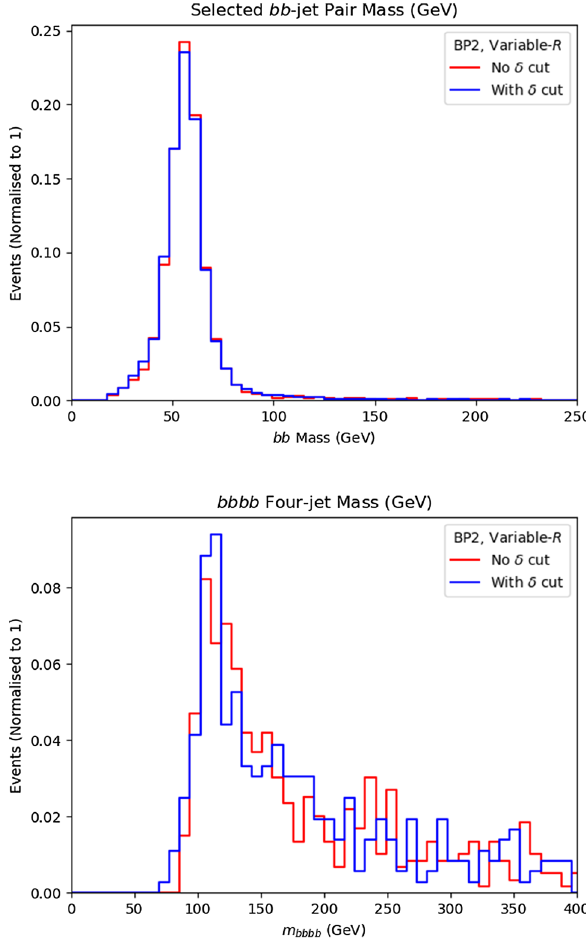
Fig. 12 Upper panel: the b -dijet invariant masses for BP1, with and without the addition of jet quality cuts as defined in Eqs. (5)–(6). Lower panel: the four b -jet invariant mass. Here we have used a value of δ = 0 . 05 for BP1